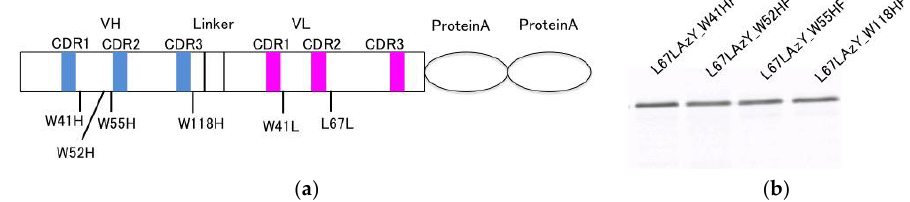
Figure 4. Expression of the Cy3-labeled mutant of L67LAzY constructed using the in vivo UAA incorporation system. ( a ) Scheme of the anti-Nef antibody gene. ( b ) Fluorescence image of SDS-PAGE of the expressed and modified Nef Q-bodies.